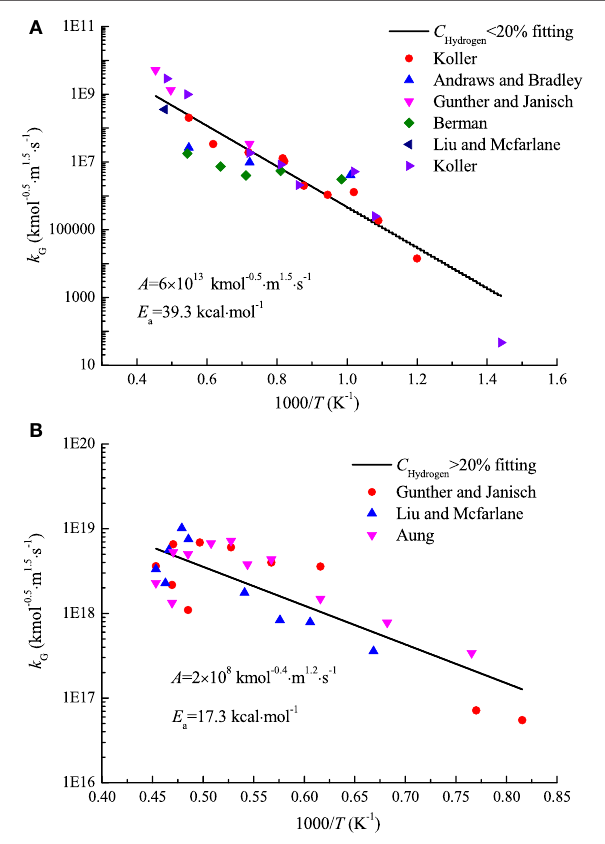
FIGURE 2 | Arrhenius plot of overall rate constant data derived from the experimental data [symbols represent experimental data; the line is a least-squares fit of the form k G = A exp ( (cid:0) E a = R T ) ]: (A) C hydrogen < 20%; (B) C hydrogen >